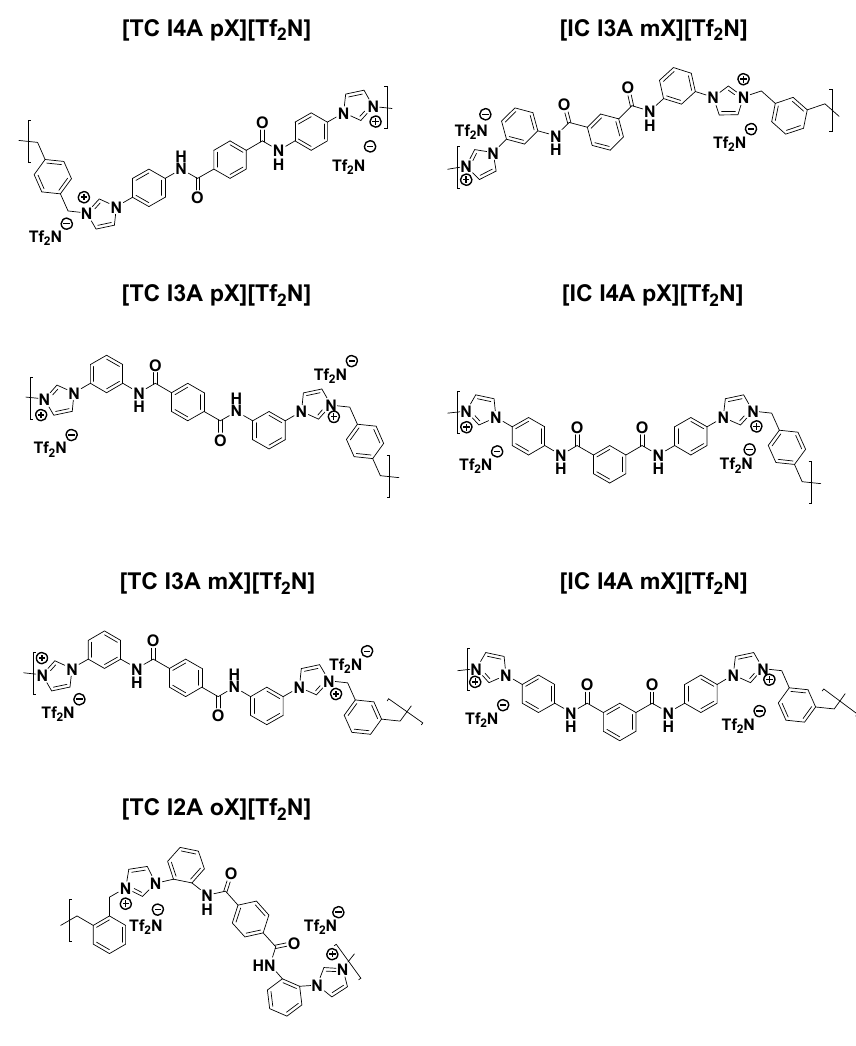
Figure 1. Seven PA-ionenes synthesized and studied in this work. Table 1. Reactant Amounts and Polymer Yields for all seven